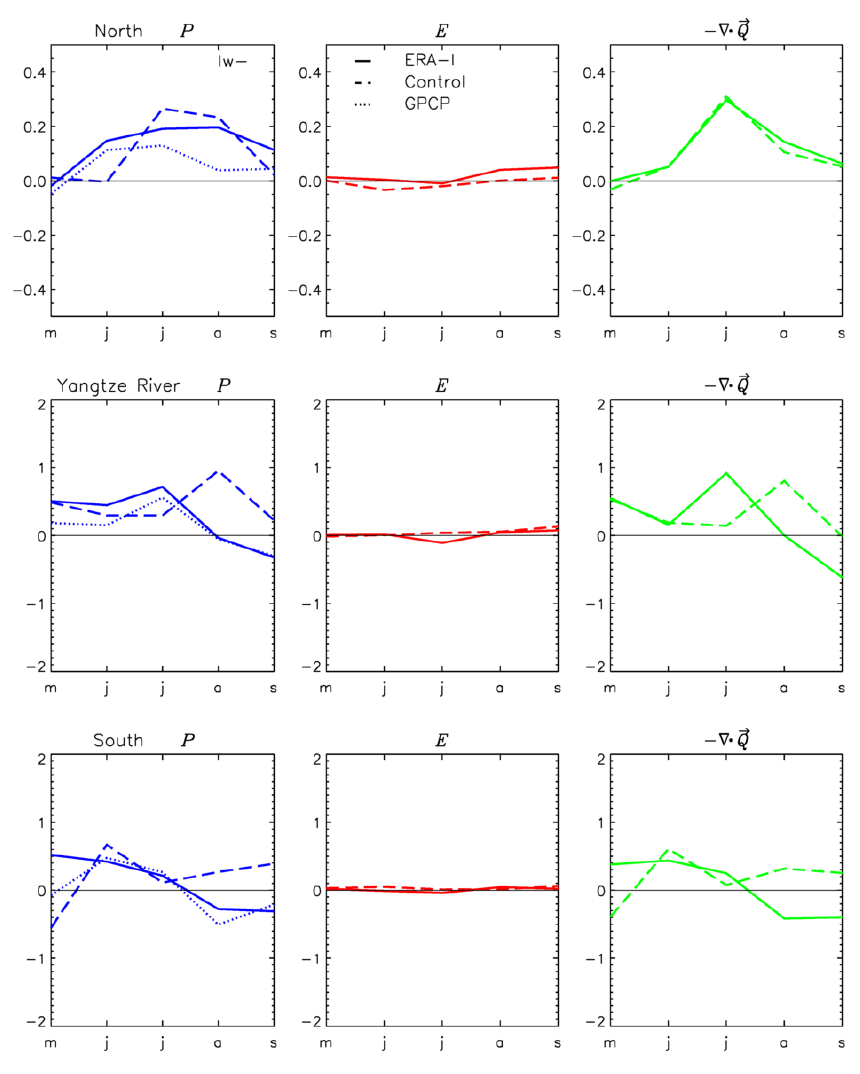
Figure 10. Same as in Figure 9, but for I W −